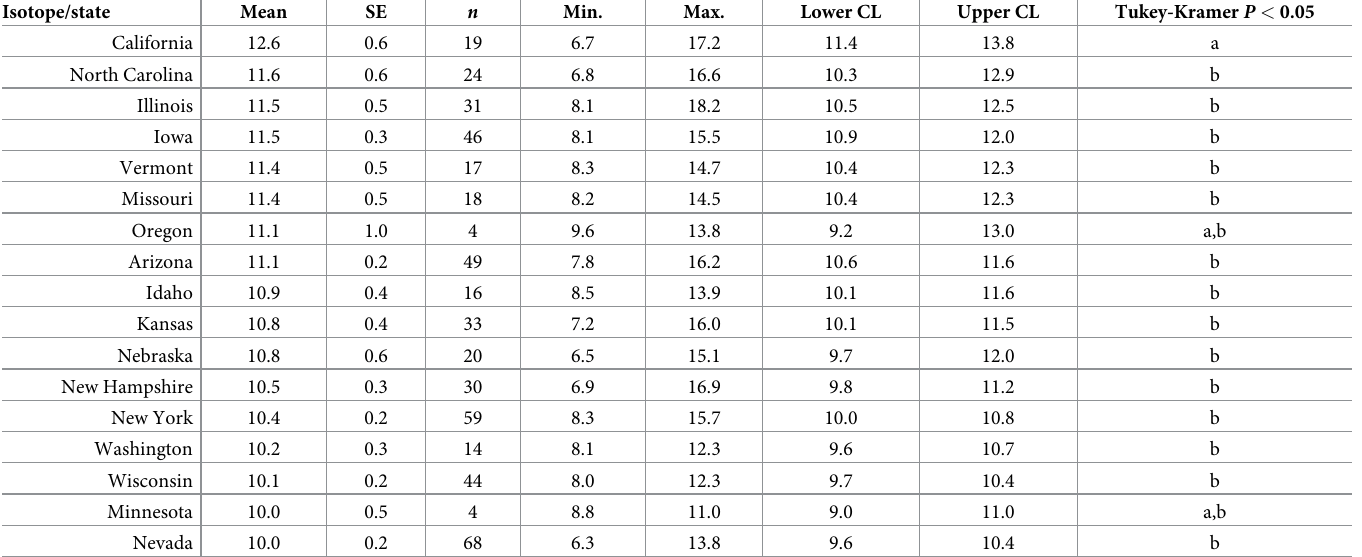
collected west of − 90˚ longitude and only three of 11 collection-state assignments were juvenile females.